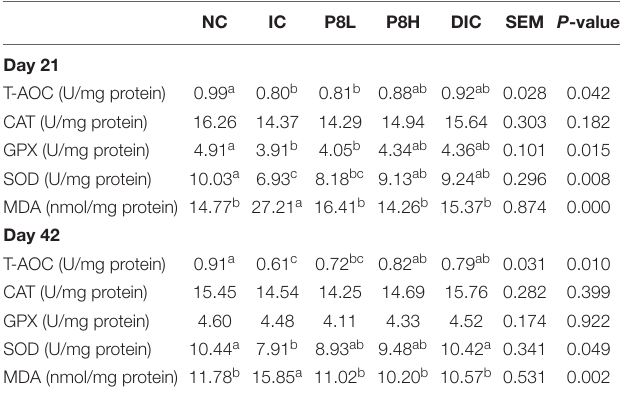
TABLE 6 | Effects of P8 on the antioxidant capacity in jejunum mucosa of Eimeria -infected broilers at days 21 and 42.